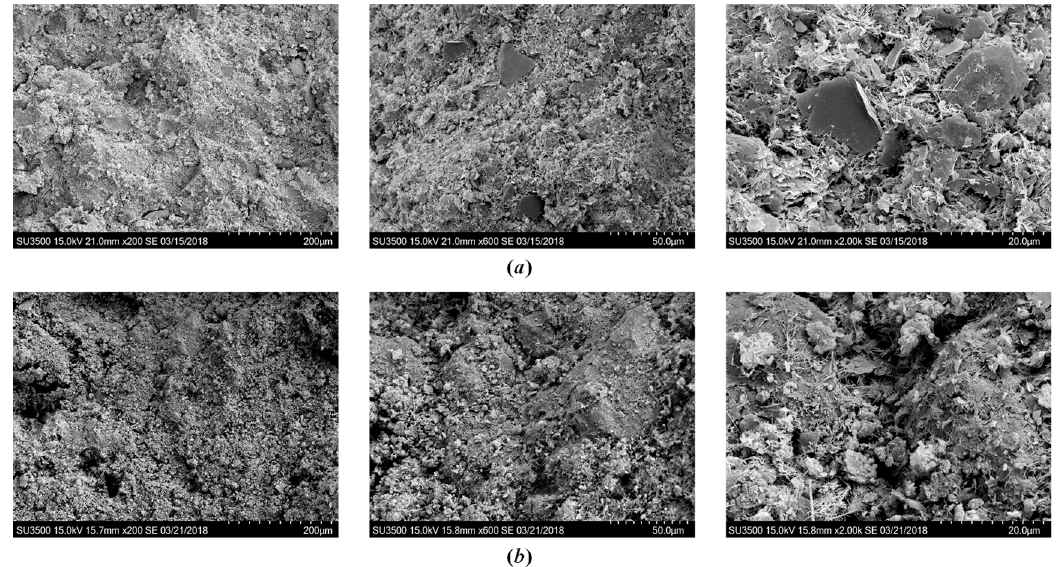
Figure 12. SEM images showing the effect of initial water content after 28 days of curing: ( a ) w 0 = 120%, ( b ) w 0 = 180%.